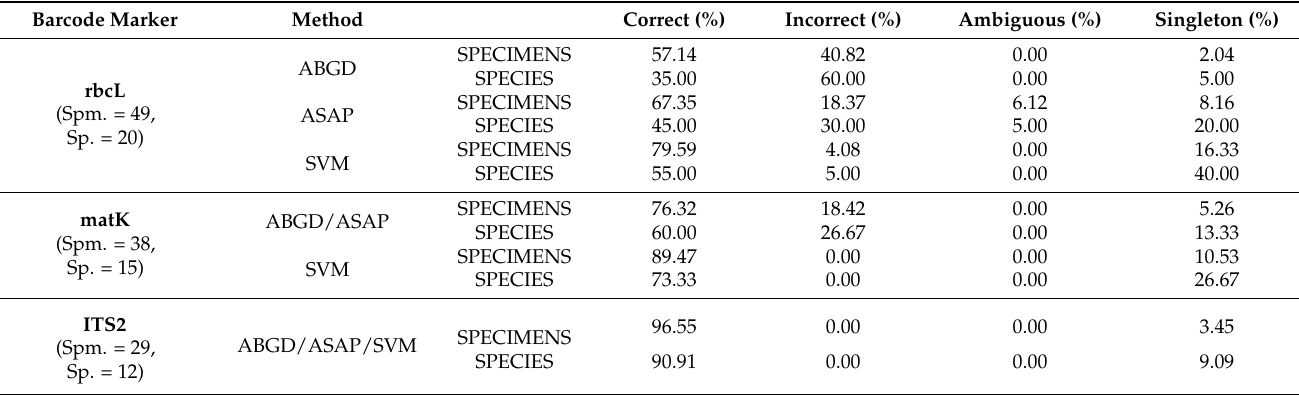
Table 1. Summary of species identification using unsupervised and supervised learning